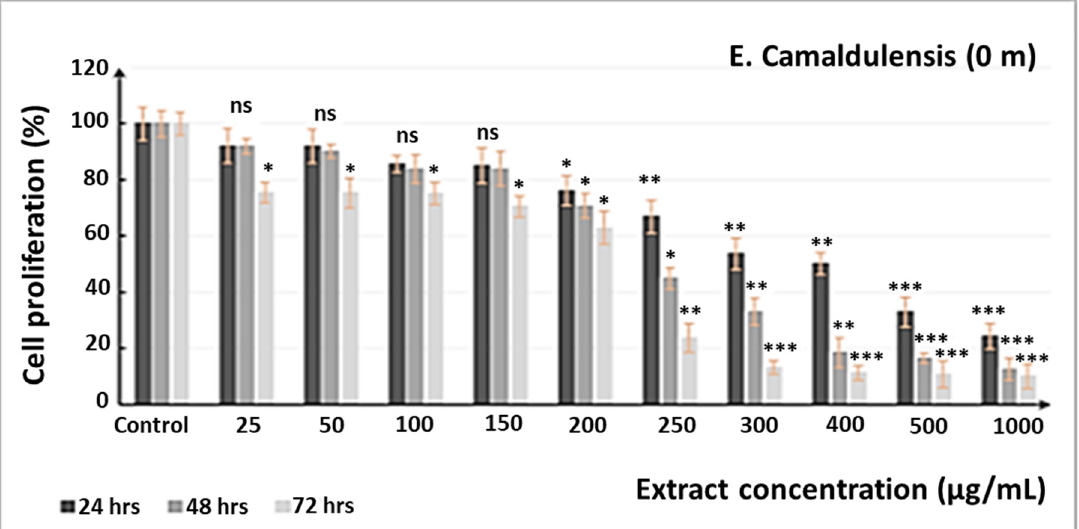
Figure 4. Cell proliferation of A549 cells after the exposure to the aqueous extract of E. camaldulensis (0 m) for 24, 48, and 72 h. Values are represented as mean +/ − SD. Statistical analysis: Paired t test or Wilcoxon test. * p < 0.05; ** p < 0.01; *** p < 0.001 in which percentage of proliferation of treated cells is compared with that of control at 24, 48, or 72 h. ns refers to non-significant result.